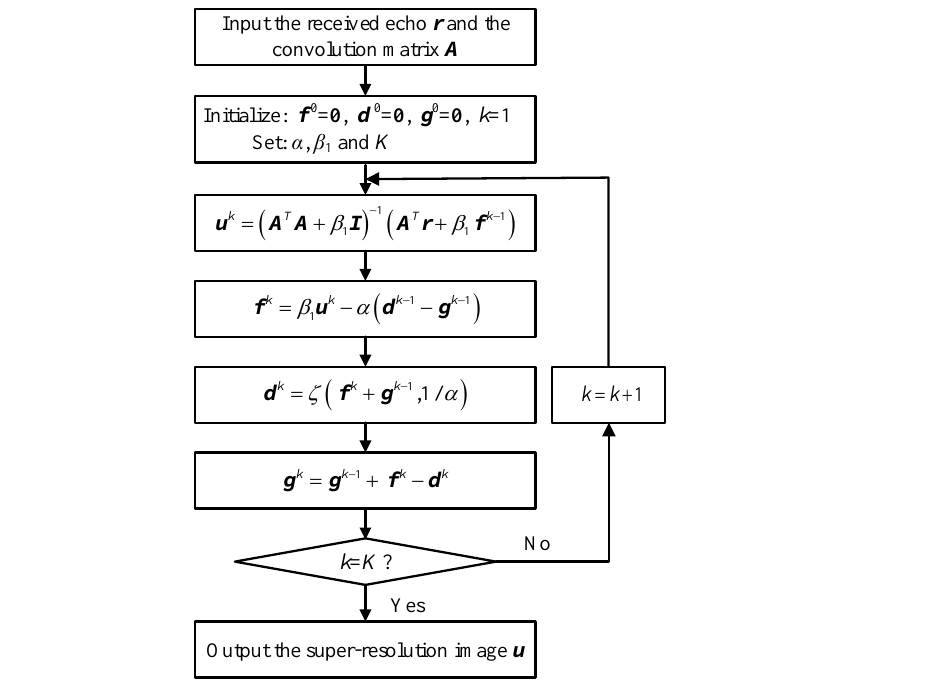
Figure 1. A flowchart of super resolution imaging using